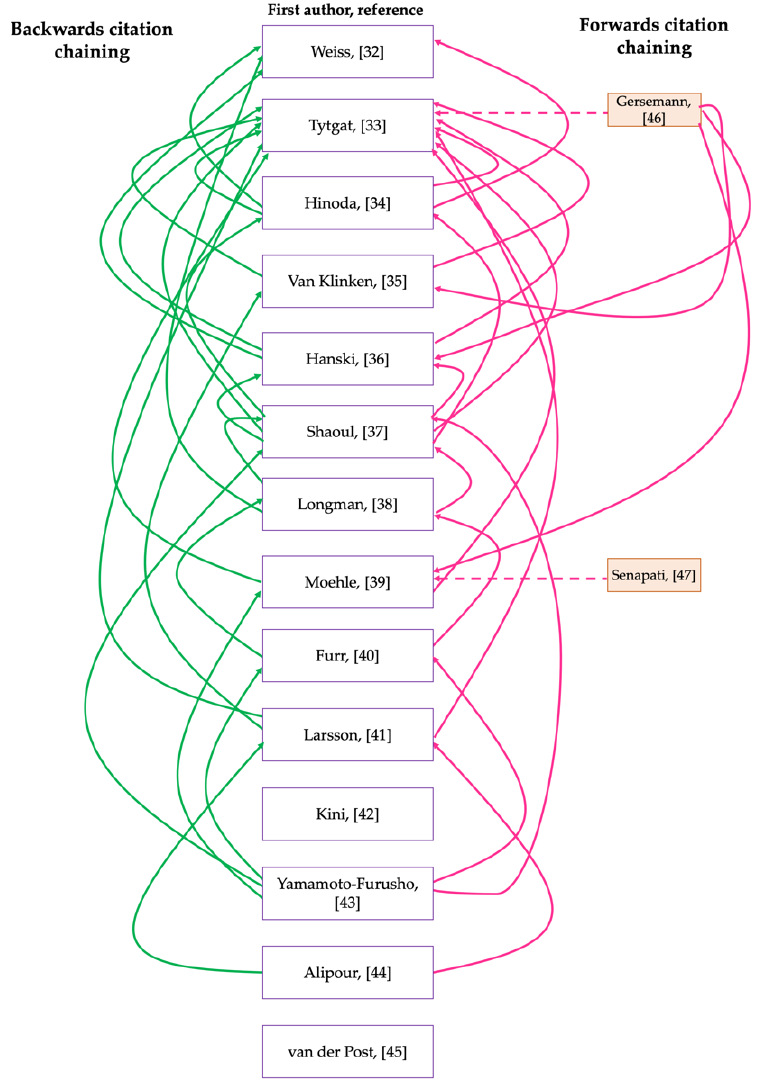
Figure 2. Citation network showing the output data of citation chaining process using key articles that were included for analysis following database searches and screening. Backwards citation chaining output data is presented on the left-hand side, here an arrow is pointed from the key articles used for citation chaining towards an article that the key article cites. Forwards citation chaining output data is presented on the righthand side, here an arrow is pointed towards the key article used for citation chaining from an article that has cited the key article. Dashed arrows are used to highlight articles that were identified by citation